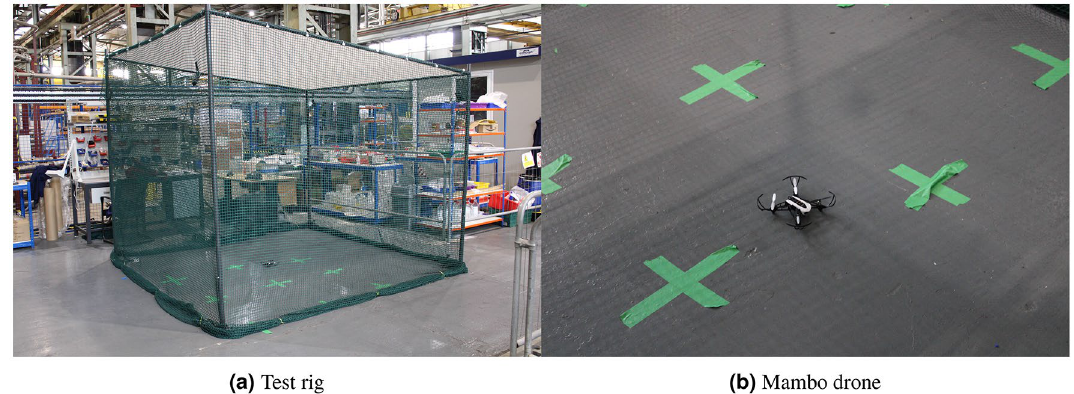
Figure 4. The hardware platform used for experimental verification of the proposed adaptive scheme.